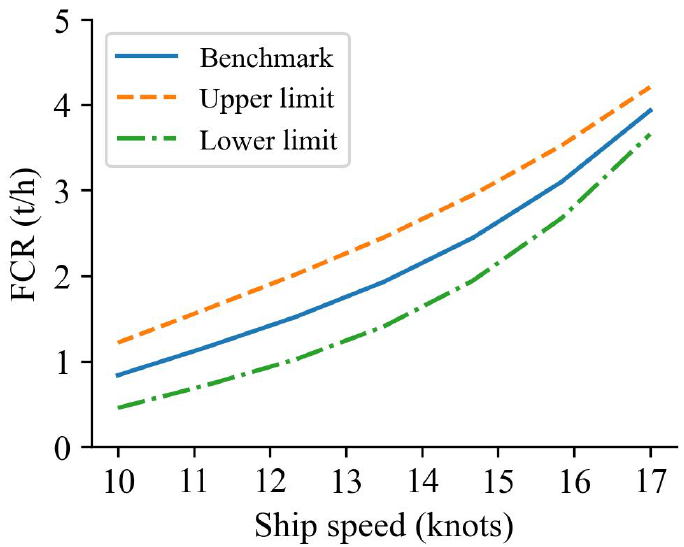
Figure 7. Fuel consumption benchmark.